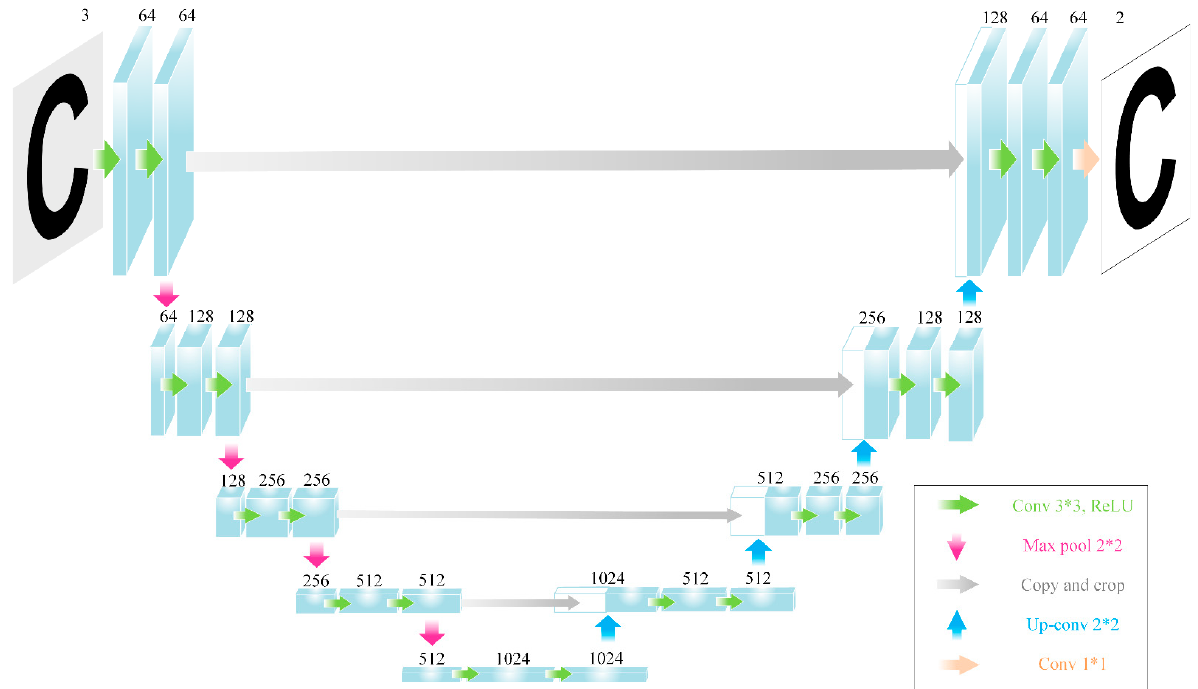
Figure 4. U-Net architecture (Reprinted from Ref. [100]. 2015, Olaf Ronneberger).